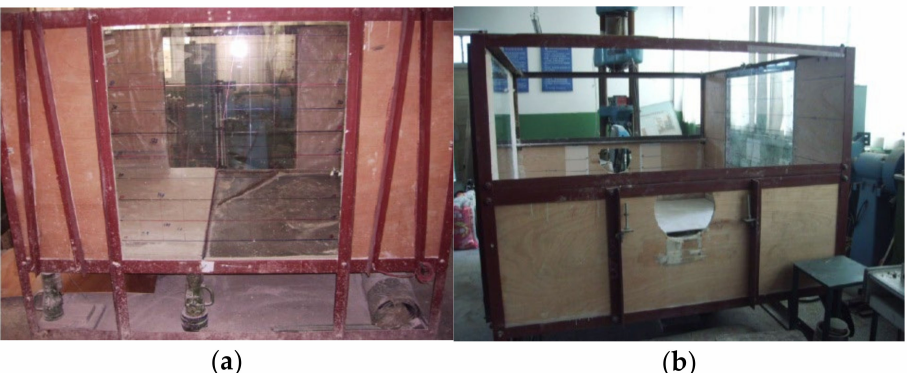
Figure 2. Schematic diagram of the model box: ( a ) front view of the model box; ( b ) side view of the model box.